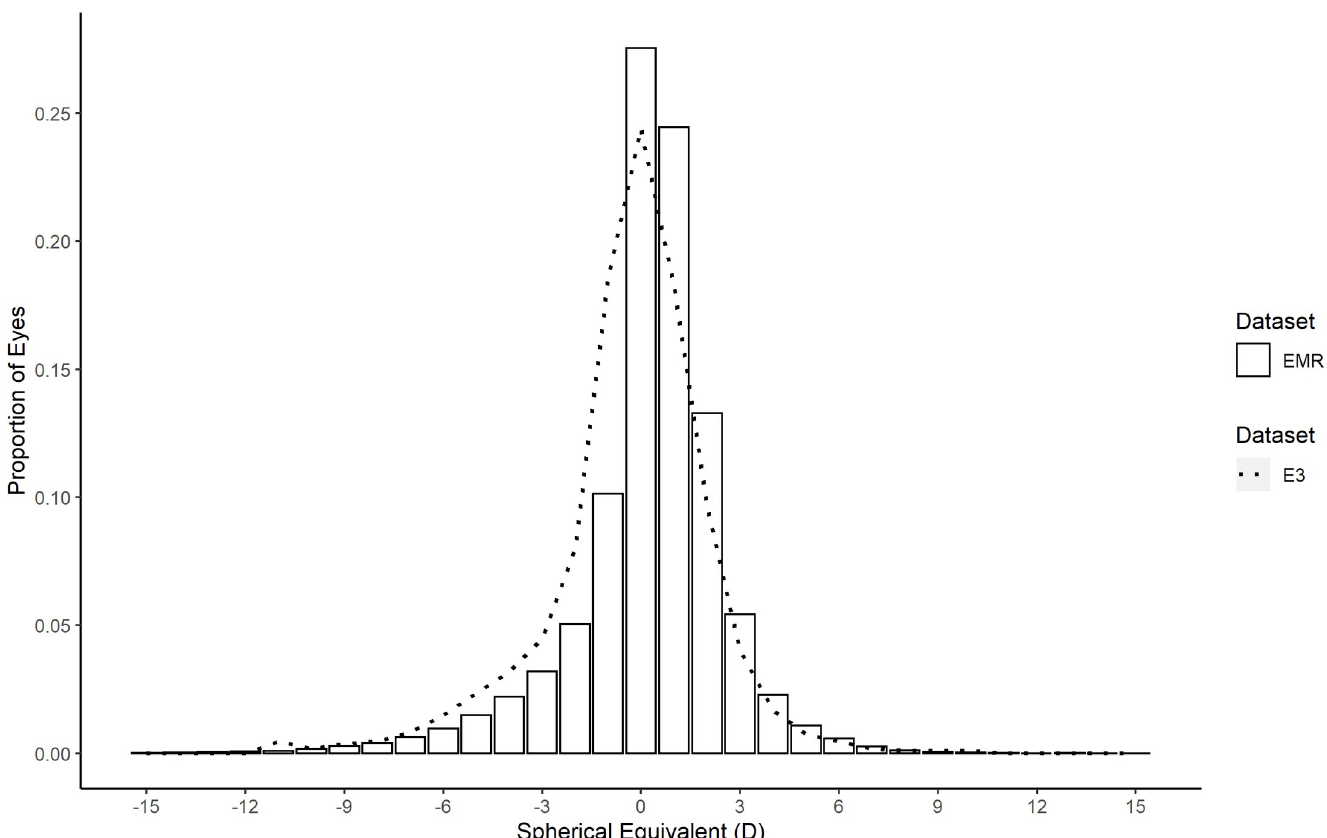
Fig 6. Comparison of spherical equivalent distribution between E3 and EMR. E3 distribution of refractive error spherical equivalent (dotted line) compared to the gender and age matched EMR distribution of right eye refractive error spherical equivalent (bars).